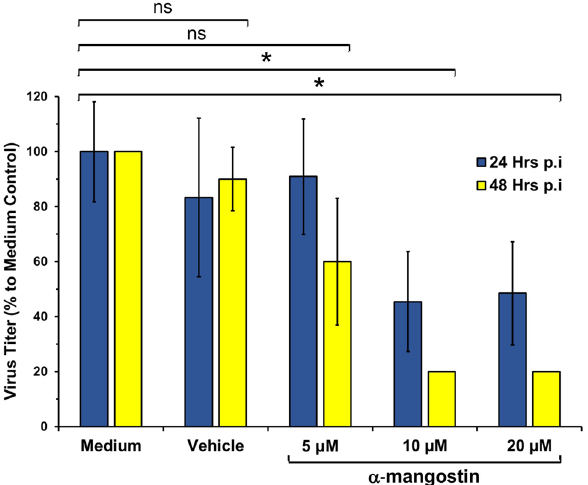
Fig. 1 The effect of α-mangostin treatments to DENV replication in infected PBMC. Virus titer was measured using plaque assay method. Data were presented as percentage of virus titer to medium only con- trol. Statistical significance: ns = not significant; *p <